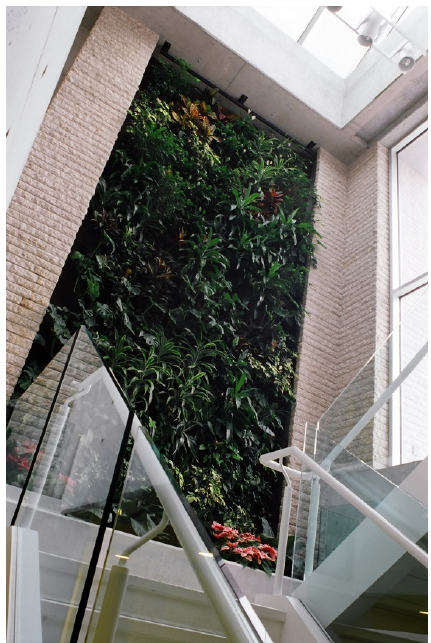
Figure 17. View of “living wall” as one ascends from the underground parking lot (Credit: Steven Evans).